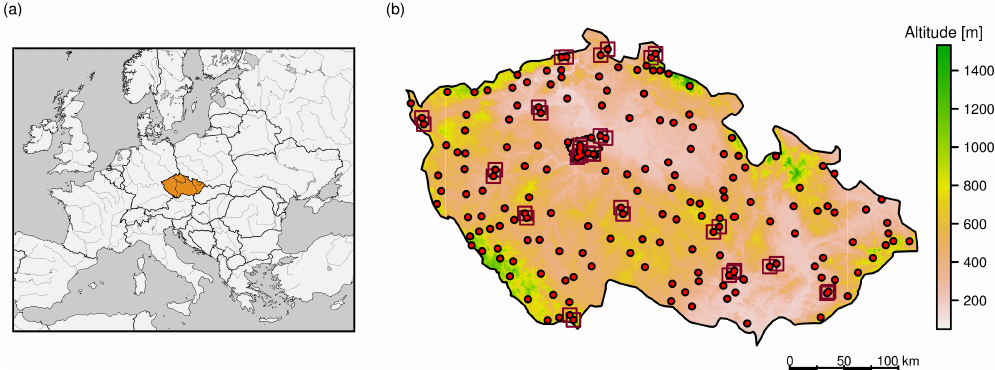
Figure 1. (a) Location of the Czech Republic in central Europe. (b) Stations (dots) used for assessing the areal-averaging effect and eval- uating the RCM simulations. Rectangles show considered (36) square neighbourhoods for assessing the areal-averaging effect for 12.5km resolution. Altitude is indicated by